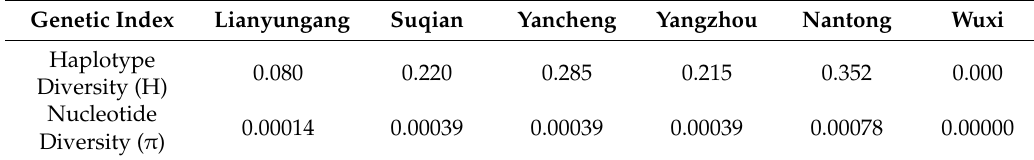
Table 1. Parameters of genetic diversity of six B. tabaci MED populations.